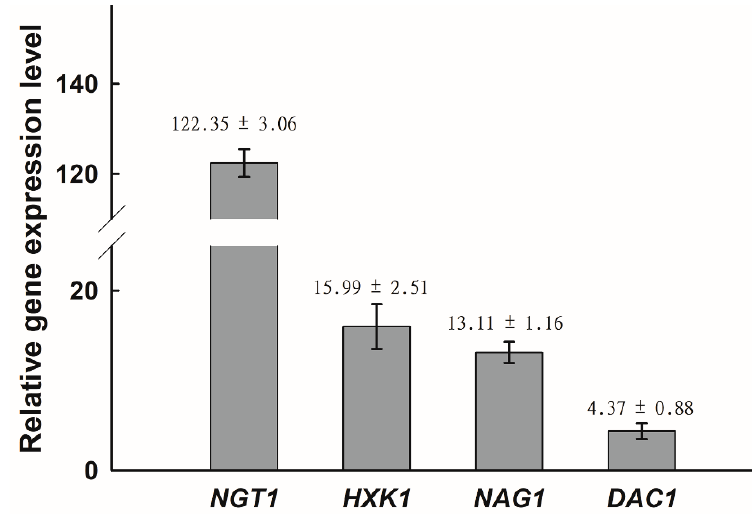
Figure 2. Relative expression of NGT1 , HXK1 , NAG1 , and DAC1 was significantly enhanced on GlcNAc-containing media relative to glucose-containing media. The upregulation of NGT1 , HXK1 , NAG1 , and DAC1 upon growth on Lee’s medium with GlcNAc, as compared to Lee’s medium with glucose at 25 °C, was assessed via qRT-PCR, with C. tropicalis actin (ACT1) being used to normalize gene expression. Gene expression was further normalized, such that expression levels on Lee’s glucose agar plates were set to 1. The average fold change ± SD is shown above the bar for each gene. Data are means ± SD from five independent biological replicates.